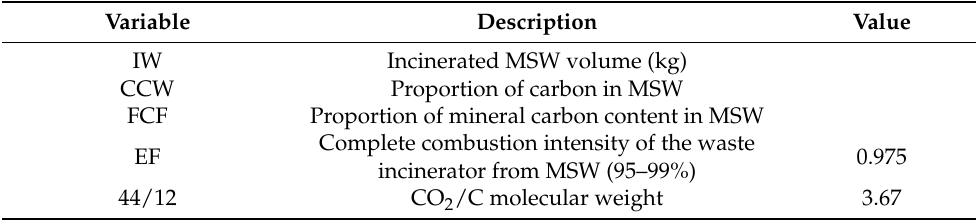
Table A1. Variables/factors needed to calculate the GHG generated linked to incineration [93]. Variable Description